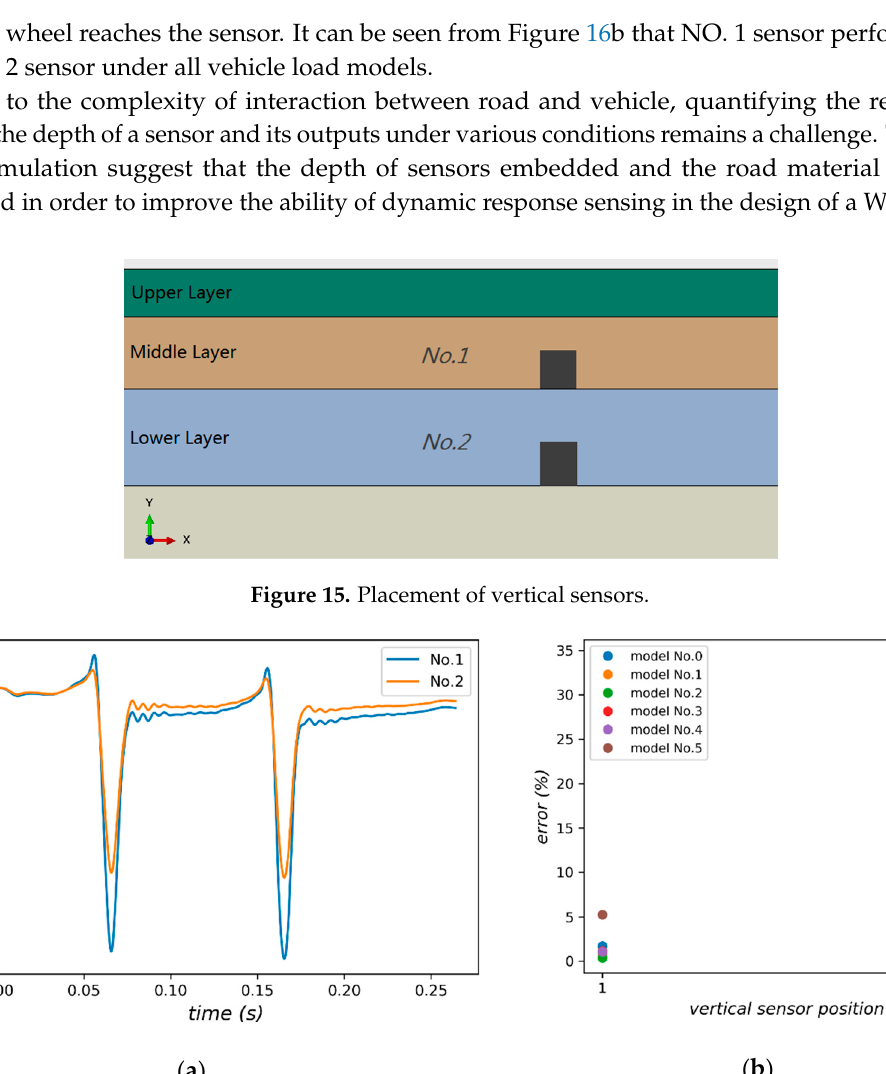
Figure 16. ( a ) Signal of vertical sensor located in different depth; ( b ) Relative errors of vertical sensors in different depth.